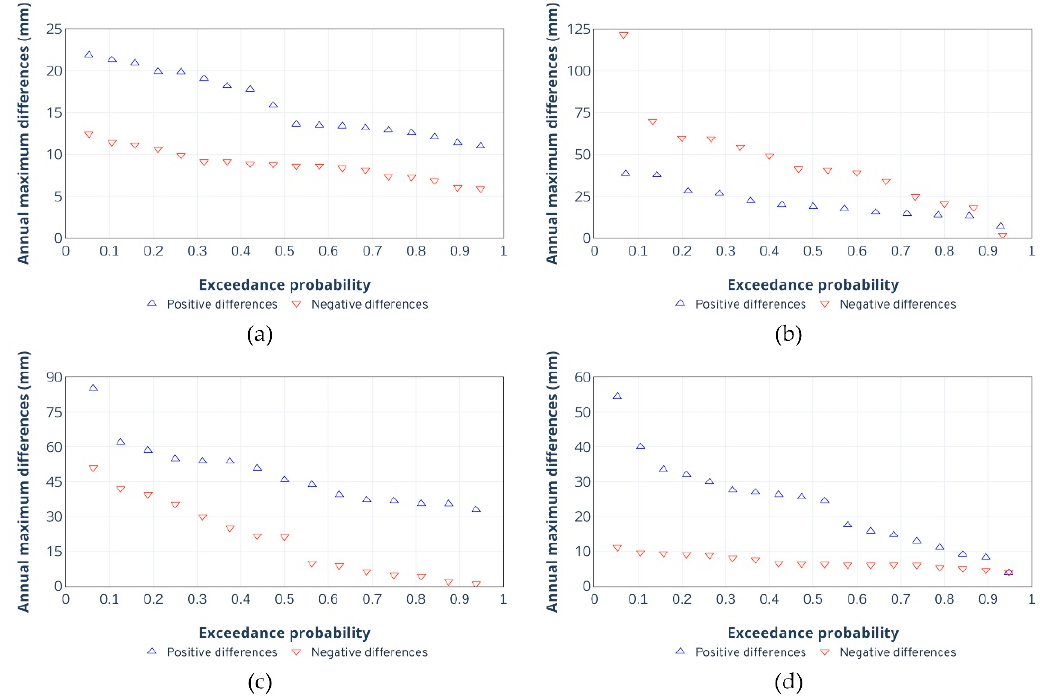
Figure 6. Results of the maximum annual differences between the precipitation estimated by the CMORPH algorithm and the precipitation observed in the station, for some of the analyzed stations.